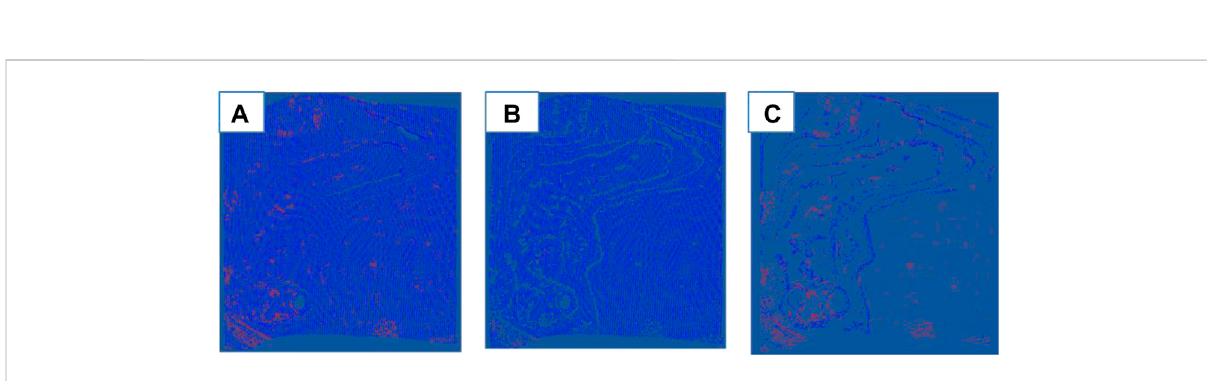
Figure 16. Figure 16A and Figure 16C show that out of these 15 samples, there are three samples where our method is second lowest and fi ve samples where our method is second